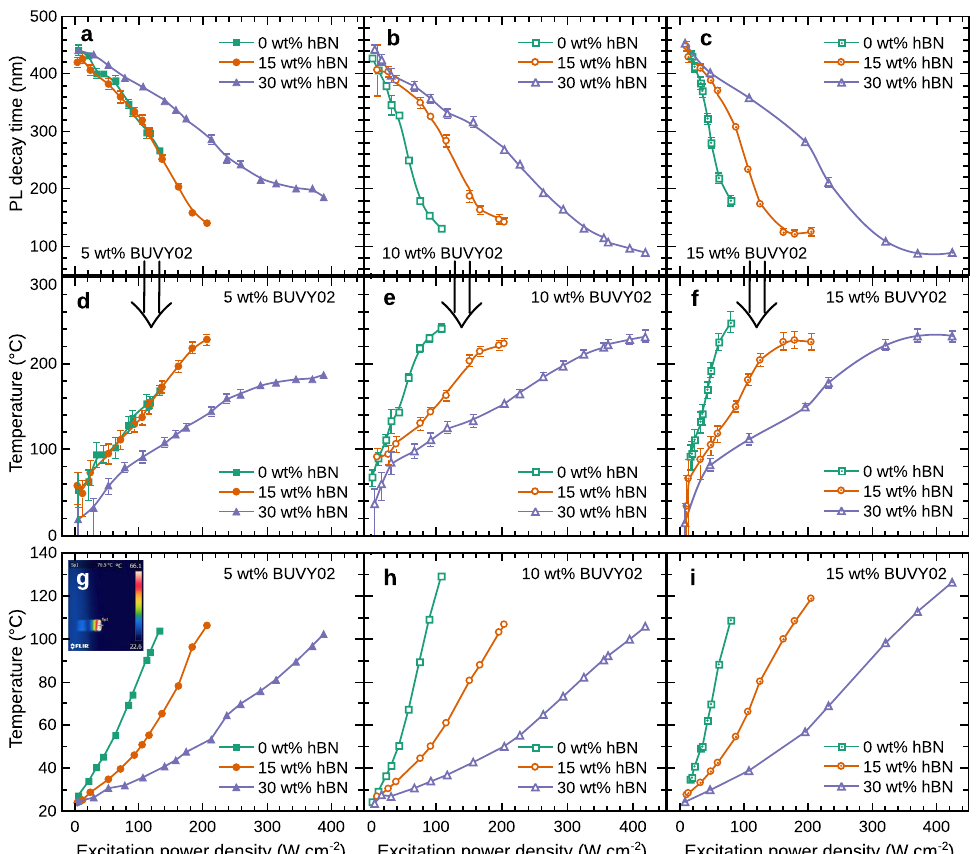
Figure 5. Parameters of the phosphor converters for different LD excitation power densities. ( a – c ) The decay time values as functions of LD excitation power density for the converters with different amounts of hBN (0 wt% green, 15 wt% orange, 30 wt% purple) and containing 5, 10 and 15 wt% of BUVY02 phosphor respectively. ( d – f ) The temperatures of the samples, extracted from the calibration curves, as functions of LD excitation power density for the converters with different amounts of hBN (0 wt% green, 15 wt% orange, 30 wt% purple) and containing 5, 10 and 15 wt% of BUVY02 phosphor, respectively. ( g – i ) The temperatures of the samples measured using a thermovisor as functions of LD excitation power density for the converters with different amounts of hBN (0 wt% green, 15 wt% orange, 30 wt% purple) and containing 5, 10 and 15 wt% of phosphor, respectively. The inset of Figure ( g ) shows a thermographic image of the sample under LD